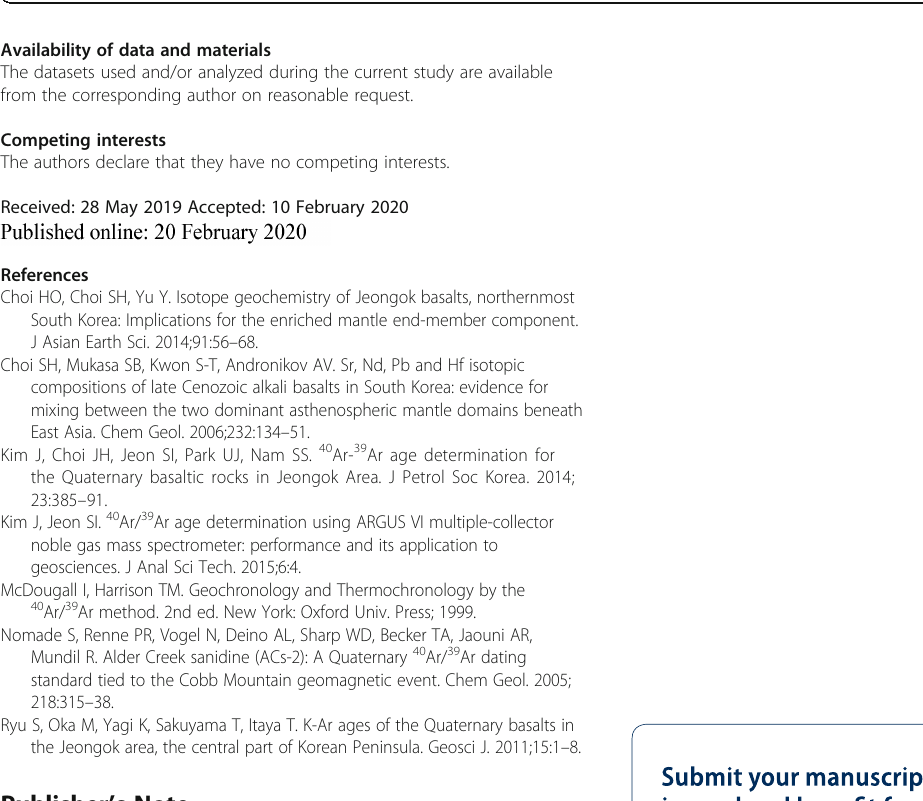
Fig. 9 Summary of age results of Jeongok basalt. Symbols: open diamonds, K-Ar ages from Ryu et al. (2011); closed diamonds, 40 Ar/ 39 Ar ages of this study. Error bar represents 1 σ